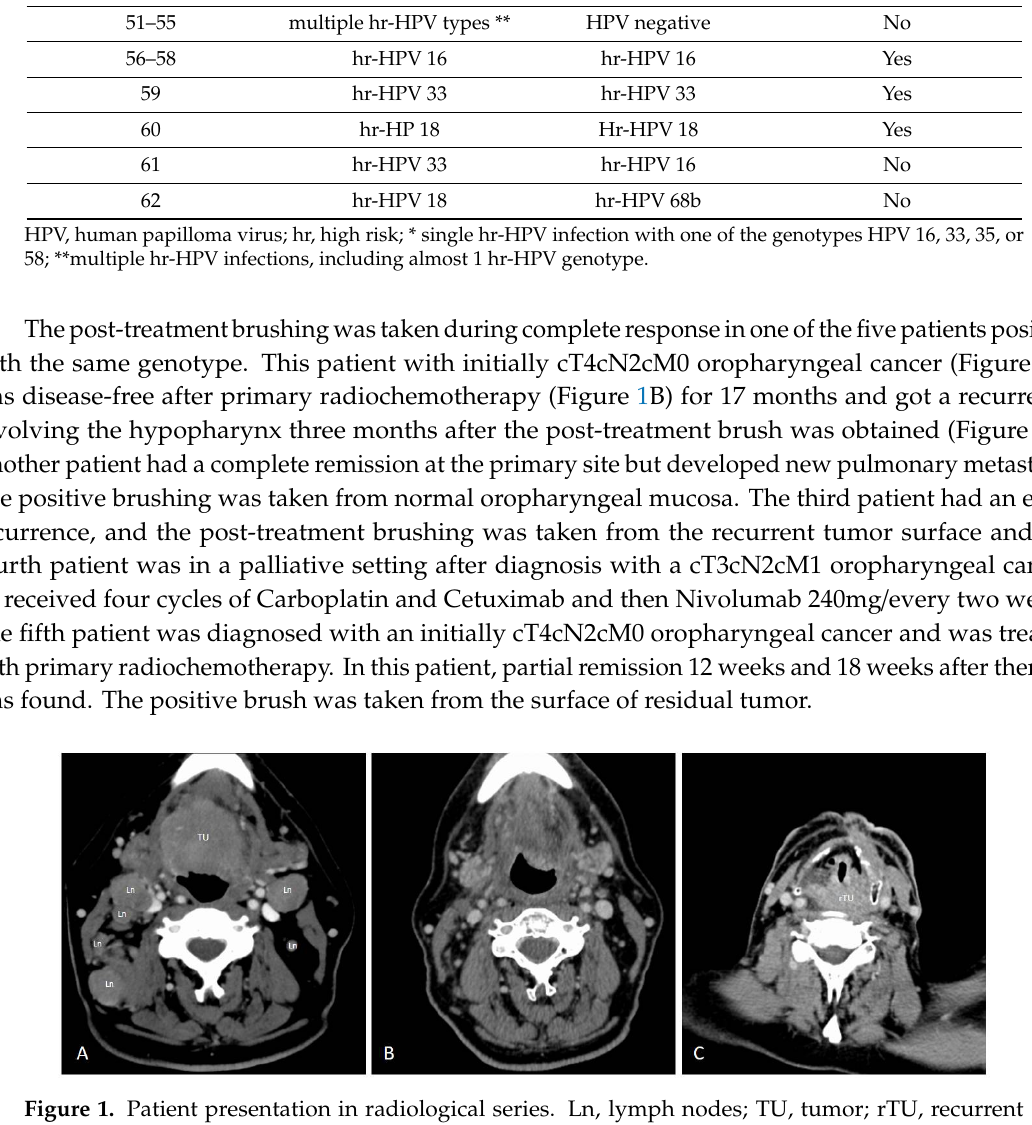
Figure 1. Patient presentation in radiological series. Ln, lymph nodes; TU, tumor; rTU,